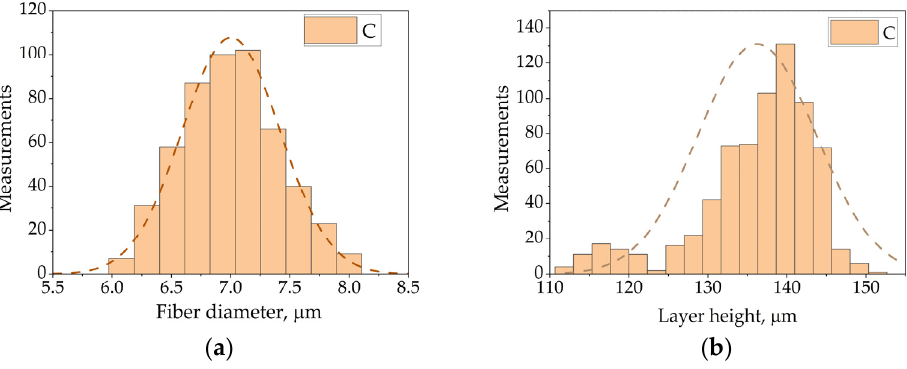
Figure 6. ( a ) Carbon fiber diameter measurements, and ( b ) the specimen’s layer height.